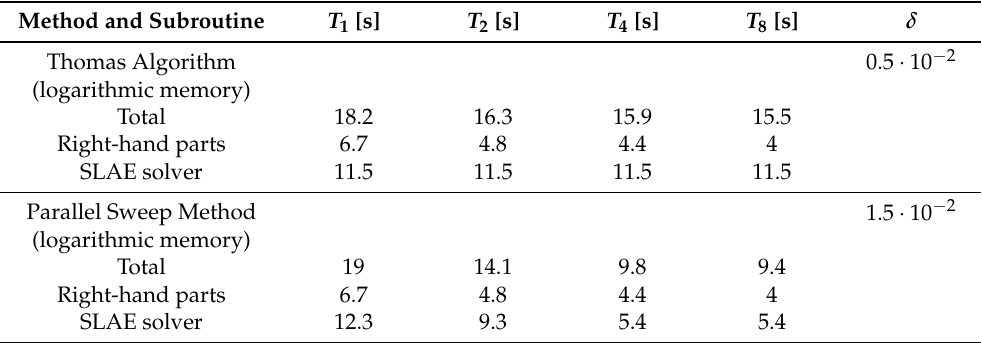
Table 4. Results of experiments for Problem 2 using the logarithmic memory approach with grid m = 32 × 2 20 , N =